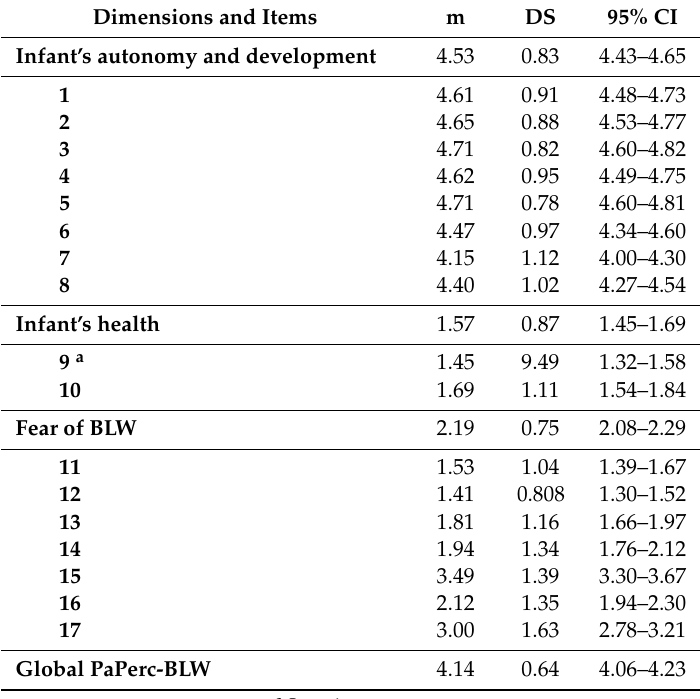
Table 3. Descriptive results of the PaPerc-BLW questionnaire. Dimensions and